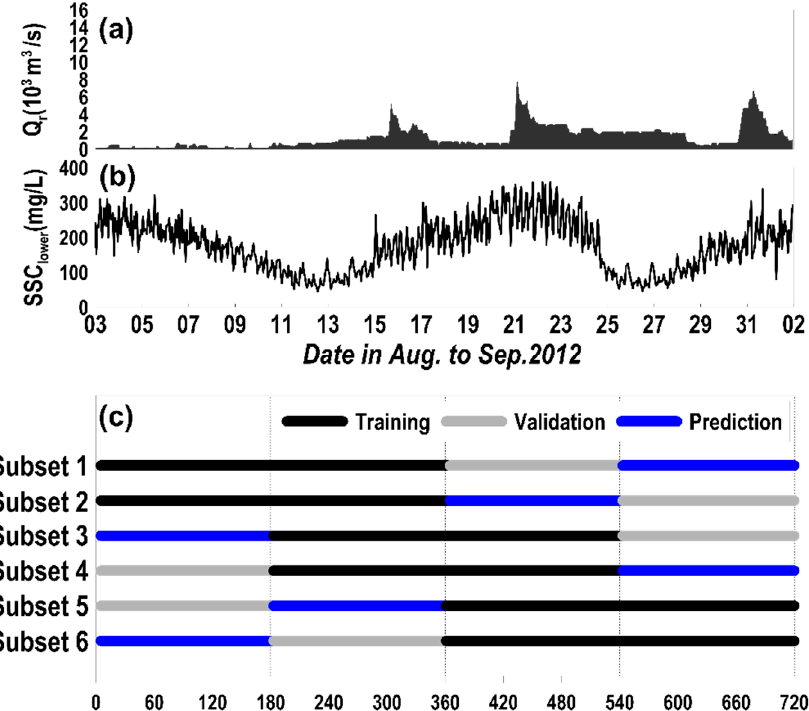
Figure 7. Subset for training, validation and prediction: ( a ) freshwater discharge from Han river, ( b ) SSC at the lower point, ( c ) subsets.